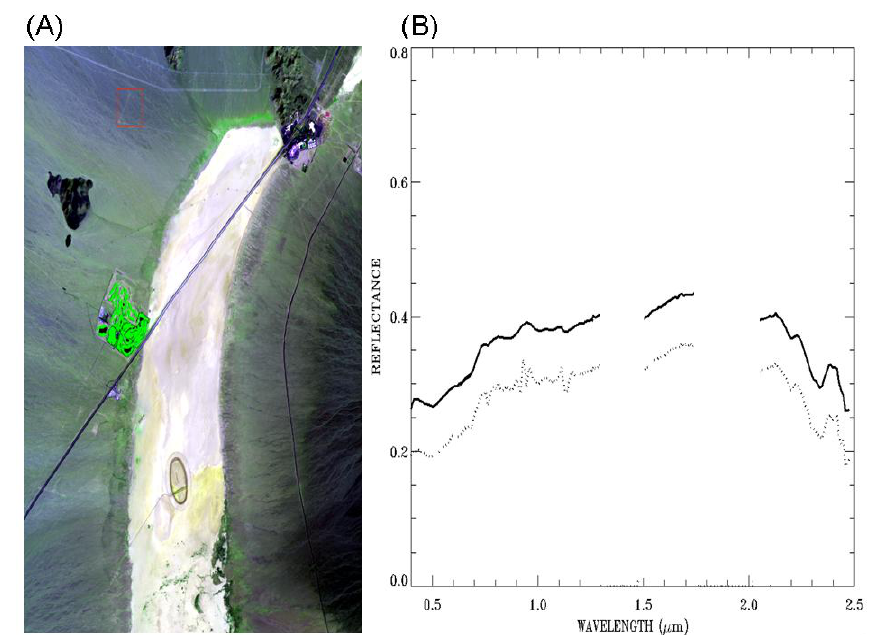
Figure 6. ( A ): a false color image (Red: 0.63 μ m; Green: 0.86 μ m; Blue: 0.47 μ m) for an AVIRIS scene over Ivanpah in California, and ( B ): an ATREM-derived surface reflectance spectrum over a soil pixel (dotted line) and the corresponding smoothed spectrum (solid line). See text for more detailed descriptions.